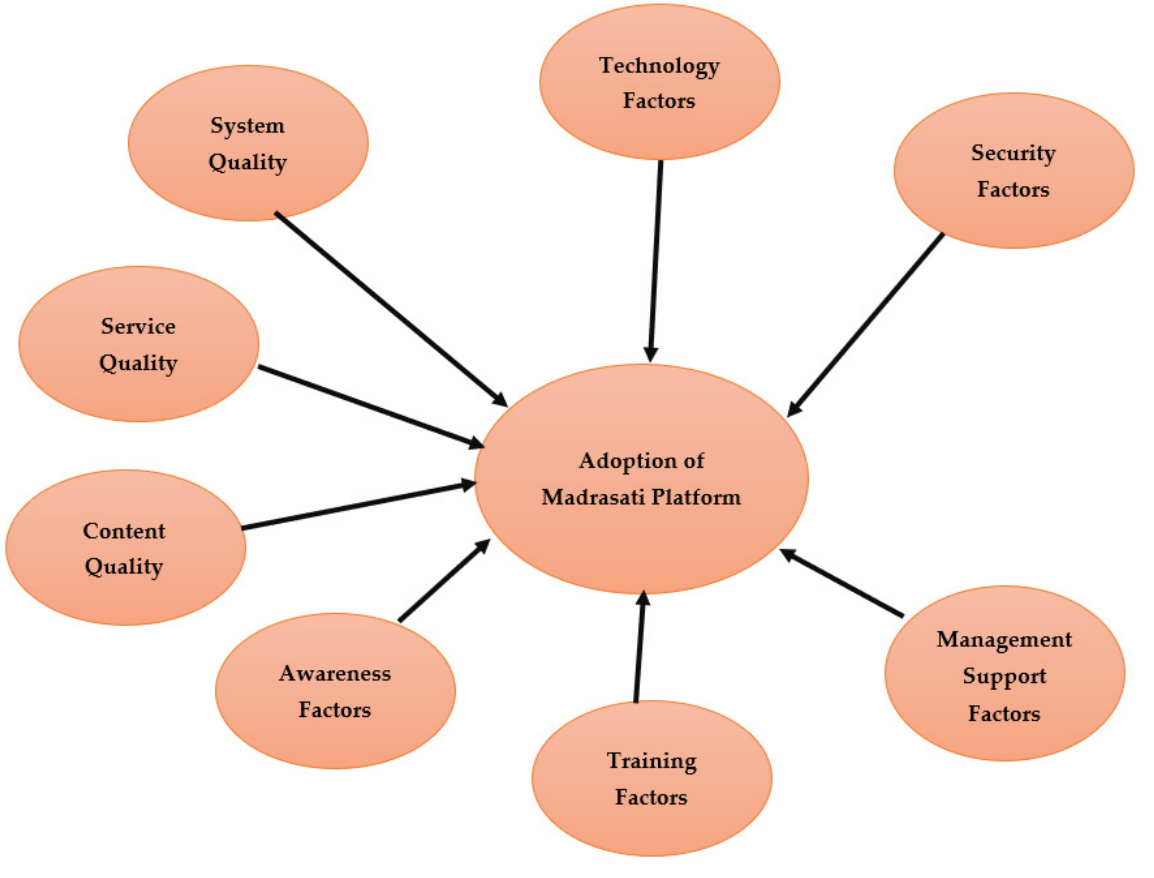
Figure 1. The Proposed Model for examining the Adoption of Madrasati Platform.